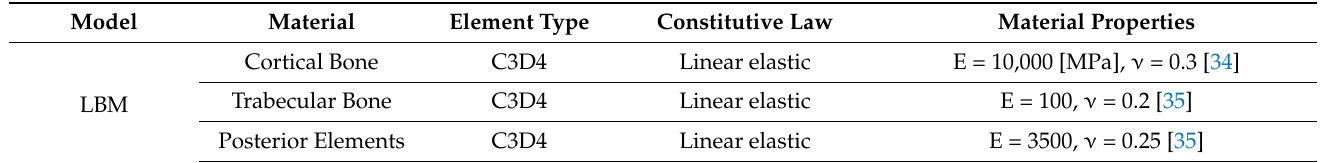
Table 1. Summary of the material properties and element types of the current